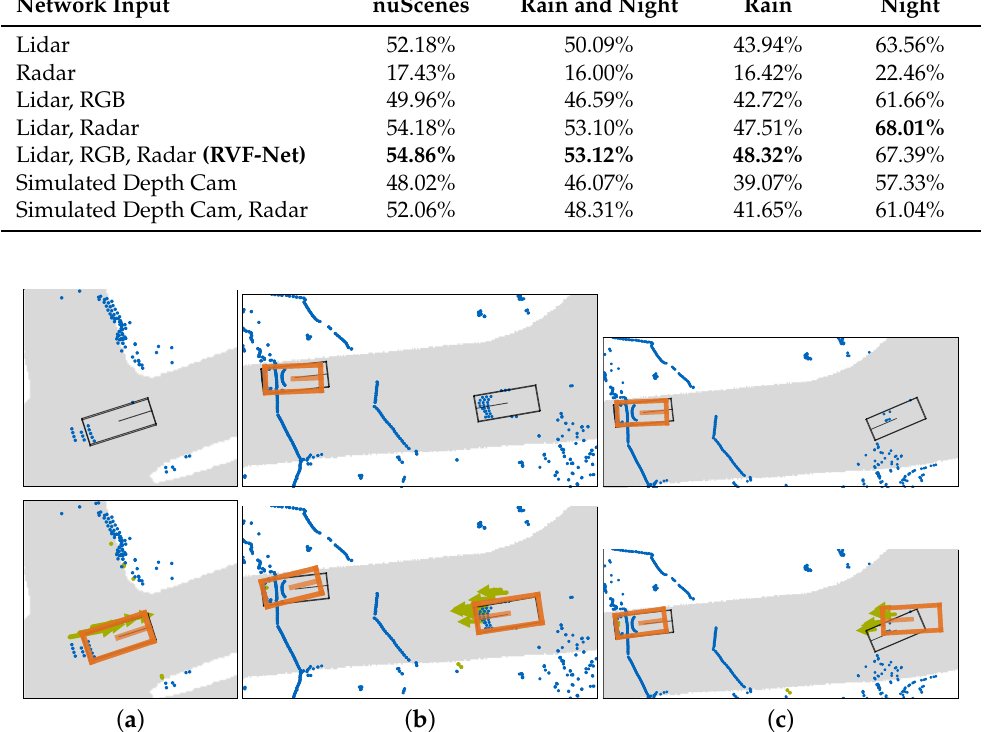
Figure 4. BEV of the detection results: Lidar and RGB fusion in the top row. RVF-Net fusion in the bottom row. Detected bounding boxes in orange. Ground truth bounding boxes in black. Lidar point cloud in blue. Radar point cloud and measured velocity in green. The street is shown in gray. ( a ) Only RVF-Net is able to detect the vehicle from the point cloud. ( b ) RVF-Net detects both bounding boxes. ( c ) RVF-Net detects both bounding boxes. However, the detected box on the right has a high translation and rotation error towards the ground truth bounding